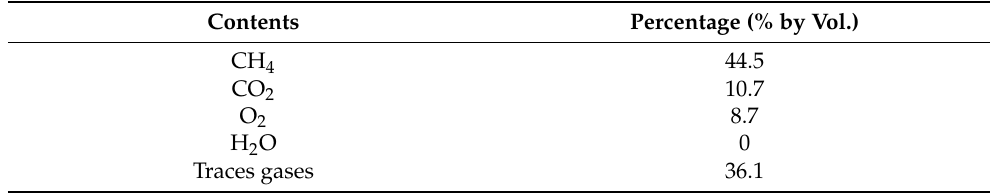
Table 1. Composition of raw biogas.